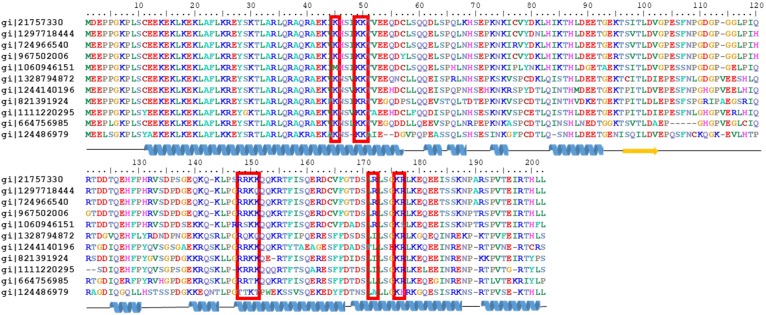
Amino acid sequence alignment of PALB2 T1 from different organisms with residues colour-coded accordingly to polarity, with mutated residues identified by red boxes, and with the secondary structure elements depicted at the bottom of alignment in cartoon representation as predicted by the Phyre server.The following sequences were used in the analysis. gi|21757330 – Homo sapiens, gi|1297718444 - Piliocolobus tephrosceles, gi|724966540 - Rhinopithecus roxellana, gi|967502006 - Macaca mulatta, gi|1060946151 - Callithrix jacchus, gi|1328794872 - Loxodonta africana, gi| 1244140196 - Enhydra lutris kenyoni, gi|821391924 - Orcinus orca, gi|1111220295 - Panthera pardus, gi|664756985 - Equus przewalskii, gi|124486979 - Mus musculus.